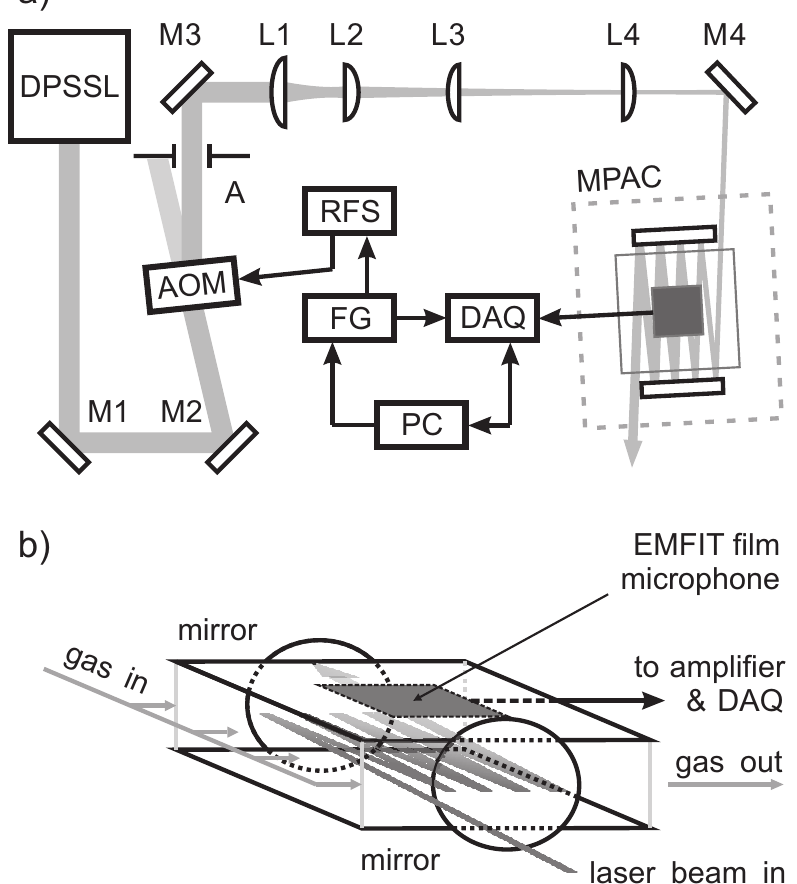
Figure 1. (a) Measurement setup: diode-pumped solid state laser (DPSSL), multipass photoacoustic cell (MPAC), function generator (FG), radio frequency power source (RFS), acusto-optic modulator (AOM), data acquisition (DAQ), personal computer (PC), mirrors (M1–M4), aperture (A), cylindrical lenses (L1–L2), and spherical lenses (L3–L4). (b) Multipass photoacoustic cell (MPAC). The reflected laser beam generates an acoustic plane wave source and excites longitudinal acoustic